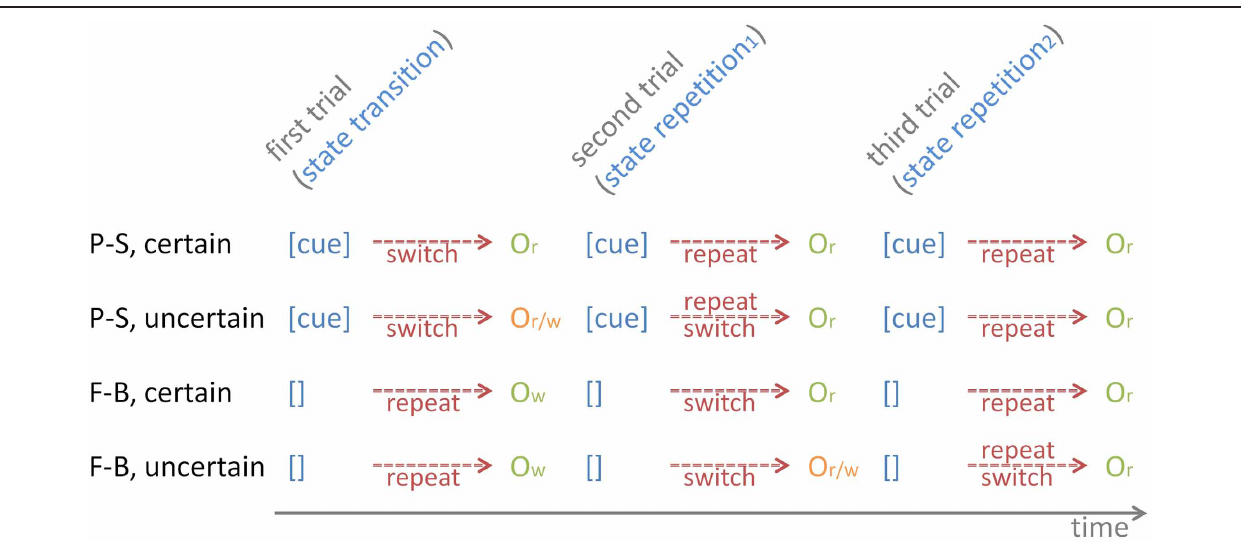
FIGURE 4 | The temporal sequence of contextual cues and outcome stimuli on P-S cuing and on F-B cuing conditions, separately for certain and uncertain conditions. The figure illustrates the initial three trials of task runs. Contextual cues are provided on P-S cuing, but not on F-B cuing (depicted as []), which leads to erroneous task-set repetitions on